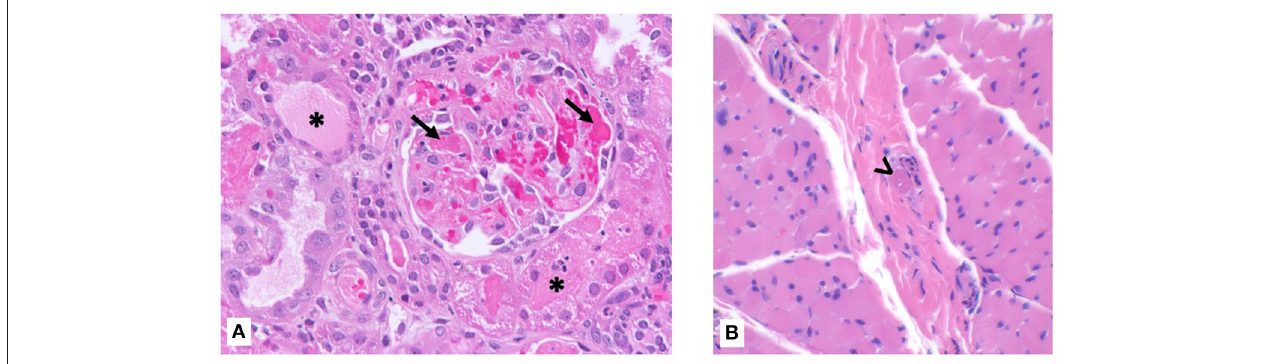
FIGURE 1 | Kidney and muscle biopsy specimens. (A) Renal biopsy showing fibrin microthrombi within glomerular capillaries (arrow) with possible early crescent formation. Tubules show diffuse injury with cytoplasmic vacuolization and focal casts (asterisk). Hematoxylin & eosin, × 400 magnification. (B) Skeletal muscle biopsy showing intravascular microthrombi within a perimysial vessel (arrowhead). Hematoxylin & eosin, × 400 magnification